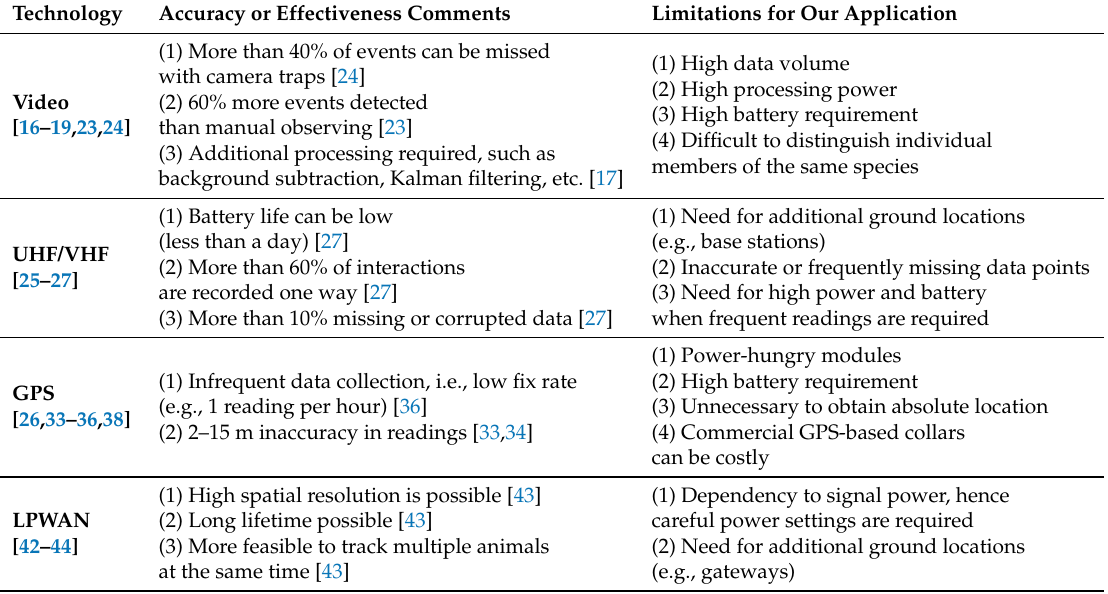
Table 1. Detailed comparison of available wildlife tracking technologies with respect to the requirements of our